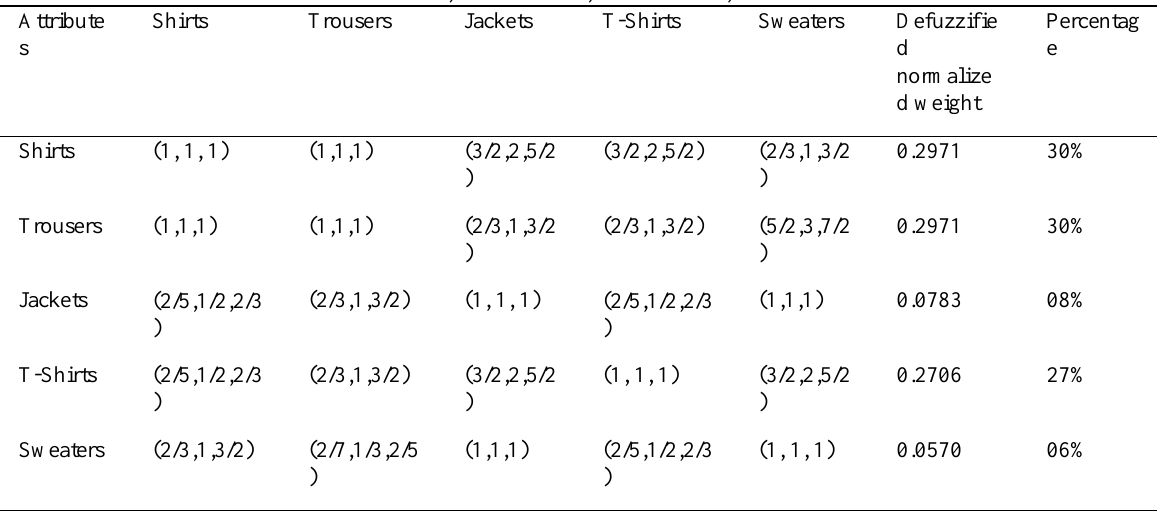
Table 7. The fuzzy comparison matrix for the “initial investment” criteria,  max